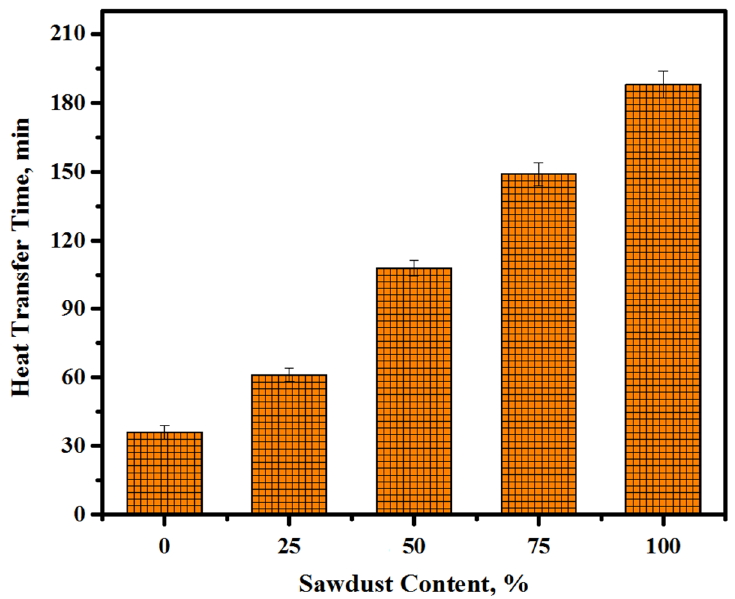
Figure 19. Thermal conductivity of the prepared concrete at various sawdust contents.